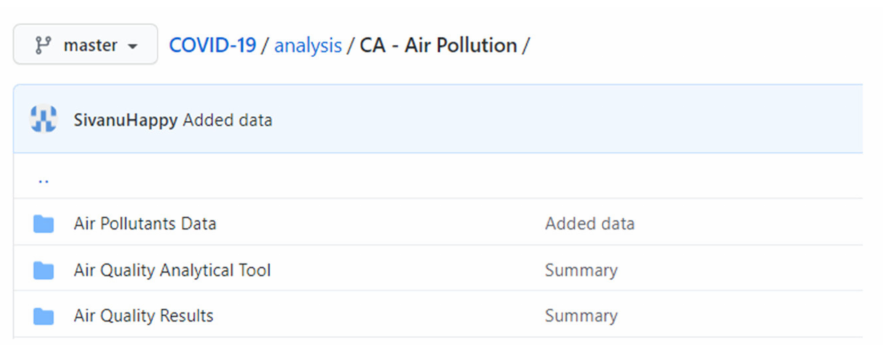
Figure 6. Air pollutants’ data, analytical tool, and results shared in the STC